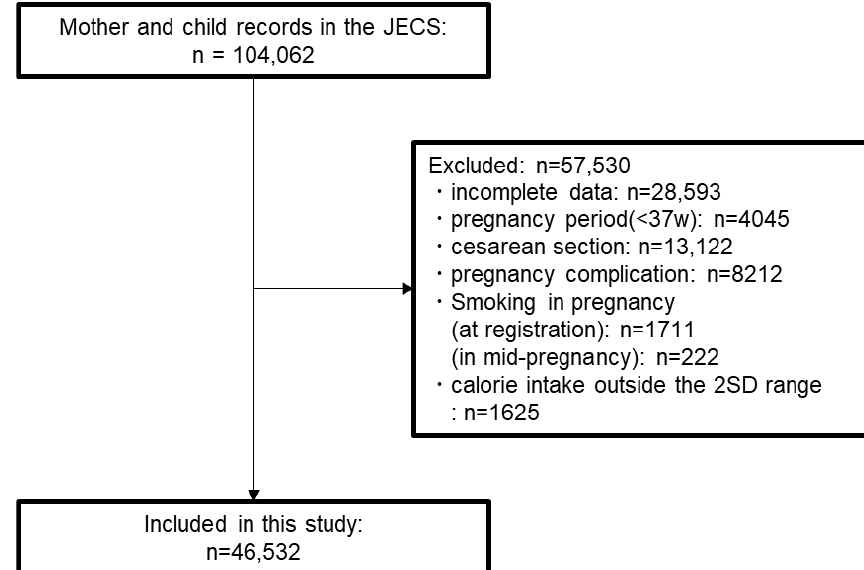
Figure 1. Flow diagram of the participants. From 104,062 records of mothers and children in the JECS, we excluded pairs who met the exclusion criteria (preterm delivery, cesarean section, any pregnancy complications, smoking during pregnancy, and outside of the mean ± 2 SD range of the energy intake from the mid-pregnancy FFQ).